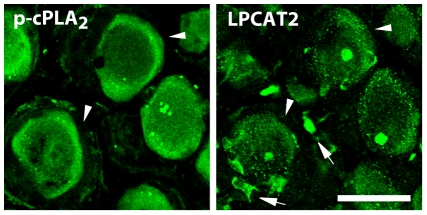
LPCAT2 is expressed in DRG neurons positive to p-cPAL2 following peripheral nerve injury.Immunohistochemical analysis using two adjacent DRG sections (singly immunostained one section with p-cPLA2 or LPCAT2 antibody) revealed that there were DRG neurons positive for both p-cPLA2 and LPCAT2 in the injured DRG (arrowheads) 7 days after nerve injury. Arrows indicate unknown cells that were strongly positive to LPCAT2-IR and negative to p-cPLA2.-IR. Scale bar, 50 µm.